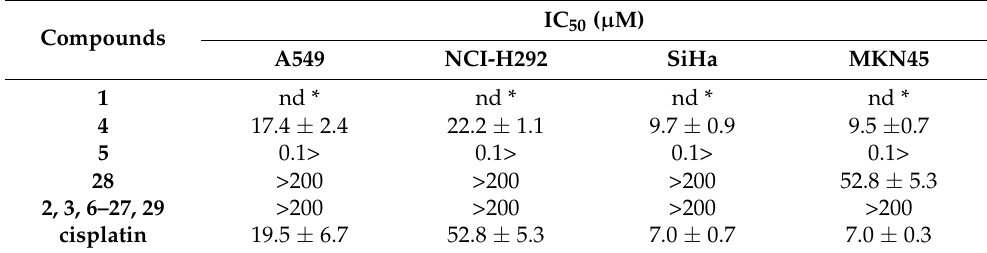
Table 5. Human Cancer Cell Proliferation Inhibition of Compounds and Positive Control.